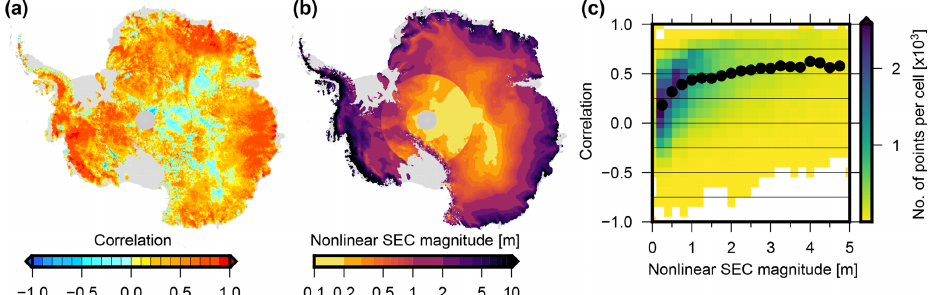
Figure 8. (a) Correlation coefficient between the SEC anomalies of the altimetry grids and the FDM over 1992–2016 after detrending. (b) Av- erage magnitude of anomalies of the altimetry time series. (c) Correlation coefficient plotted against the nonlinear SEC. The point density is color coded from yellow to blue. The black dots show the binned mean values.